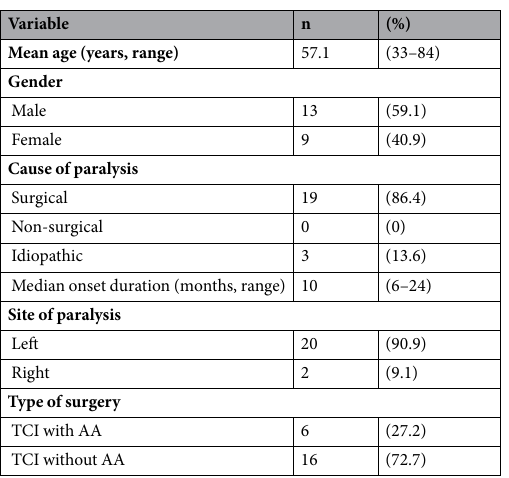
Table 1. Patient characteristics. * Abbreviations: TCI = Thyroid cartilage implantation; AA = Arytenoid